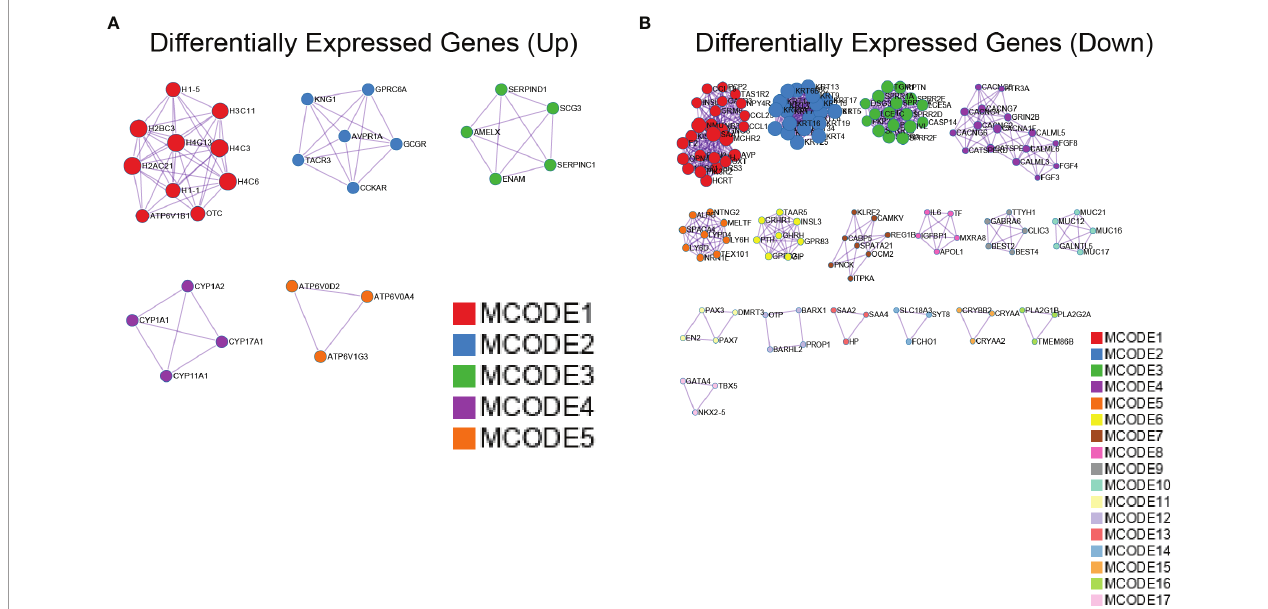
FIGURE 7 | Protein – protein interaction (PPI) network of differentially expressed genes (DEGs) with Gmfb in kidney renal clear cell carcinoma (KIRC) by Metascape. (A) Upregulated DEGs. (B) Downregulated